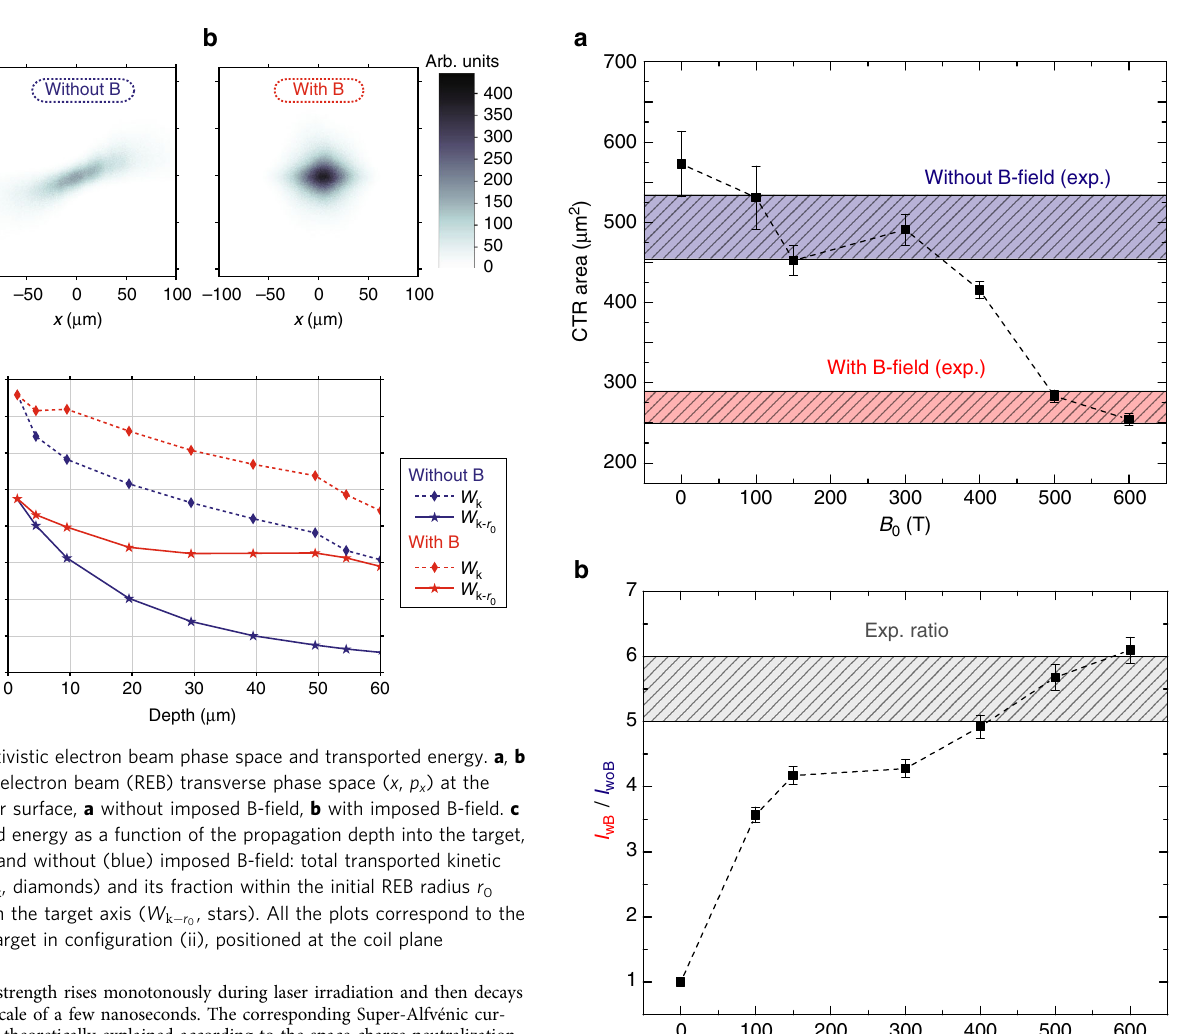
Fig. 5. Coherent transition radiation . Coherent Transition Radiation (CTR) is produced by the REB crossing the target-vacuum boundary 19,47 . Its timescale, of the order of